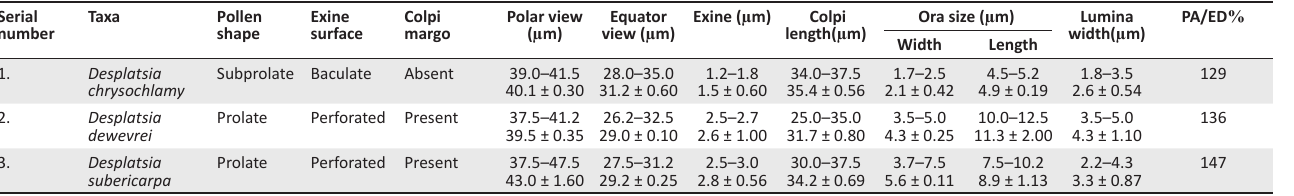
TABLE 4: Qualitative and quantitative pollen morphological characters of some Desplatsia species in West